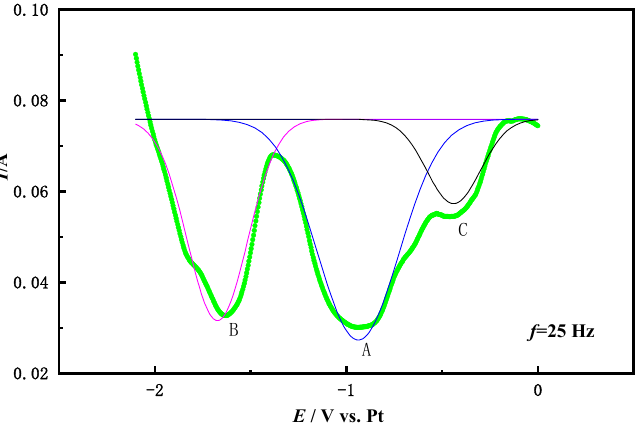
Figure 4. Square wave voltammetry of NaCl-CaCl 2 -LiCoO molten salt system (25 Hz; Fe electrode).